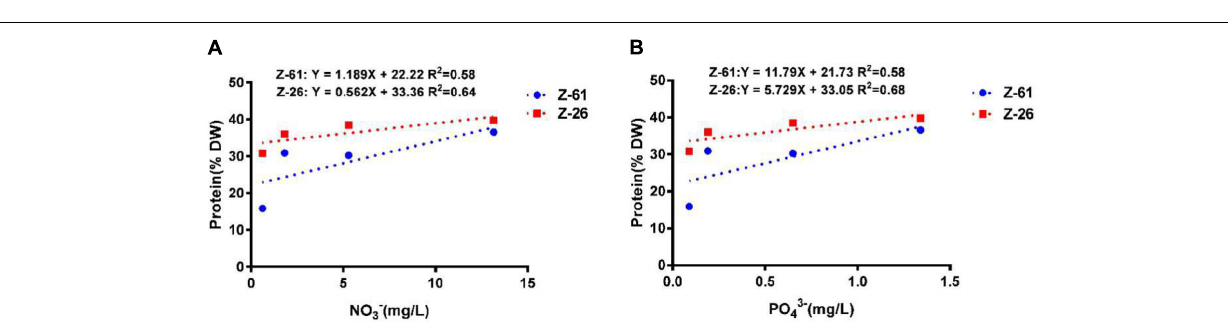
FIGURE 5 | Linear relationships between protein content in thalli and nitrogen (A) or phosphorus (B) concentrations in different culture media (blue dotted line, Z-61; red dotted line,